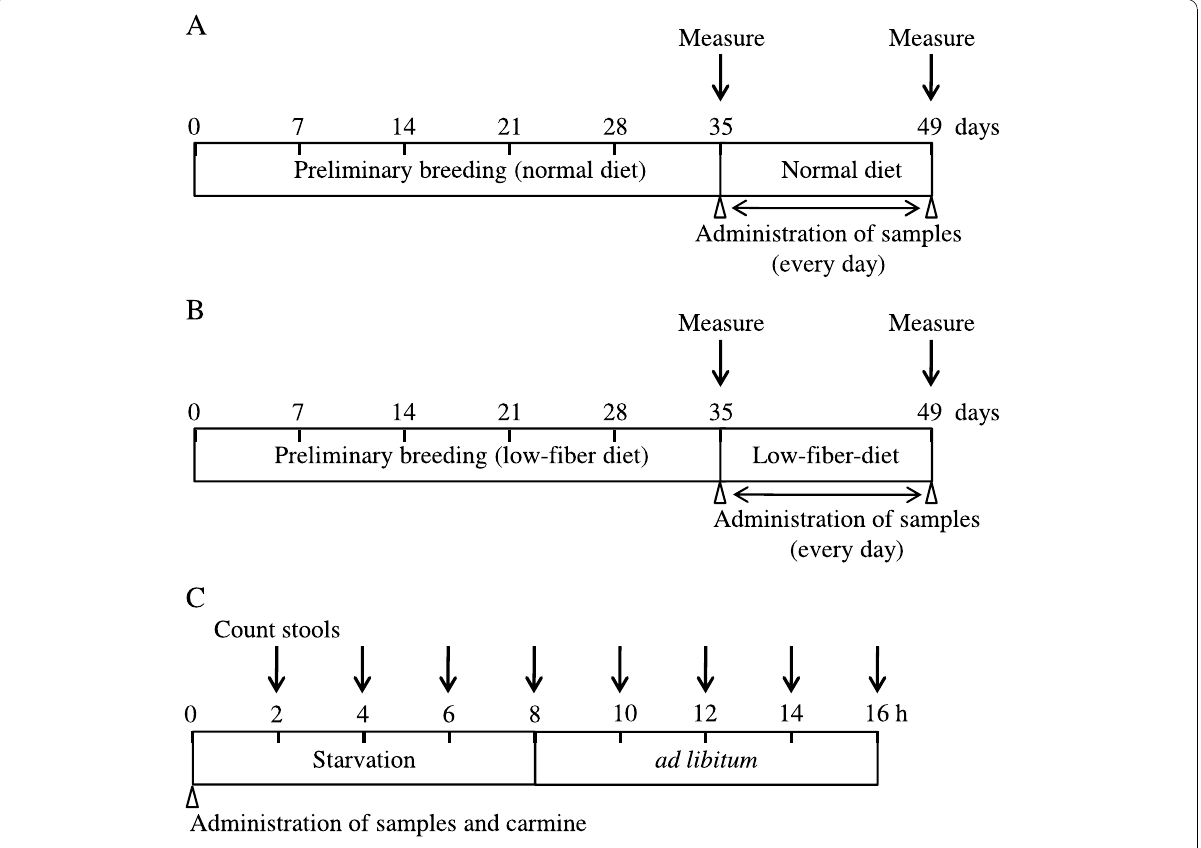
Figure 1 The schedule of examination performed in this study .